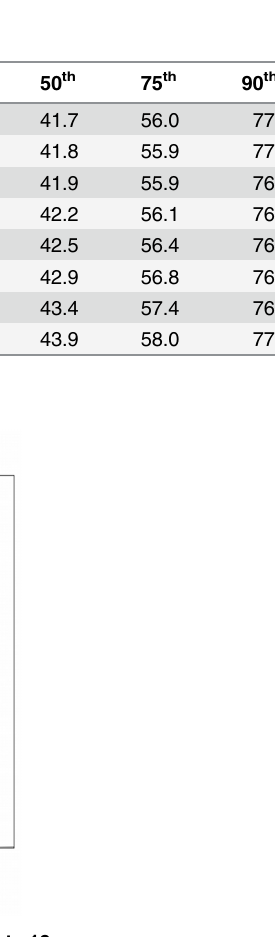
Fig 4. Percentile curves for sum of 5 skinfolds for male and female Canadian children and youth aged 6 to 19 years. doi:10.1371/journal.pone.0132891.g004 Table 6. Z-scores and percentiles that intersect the adult cutpoints for body mass index, waist circumference, and waist-to-height ratio at age 18